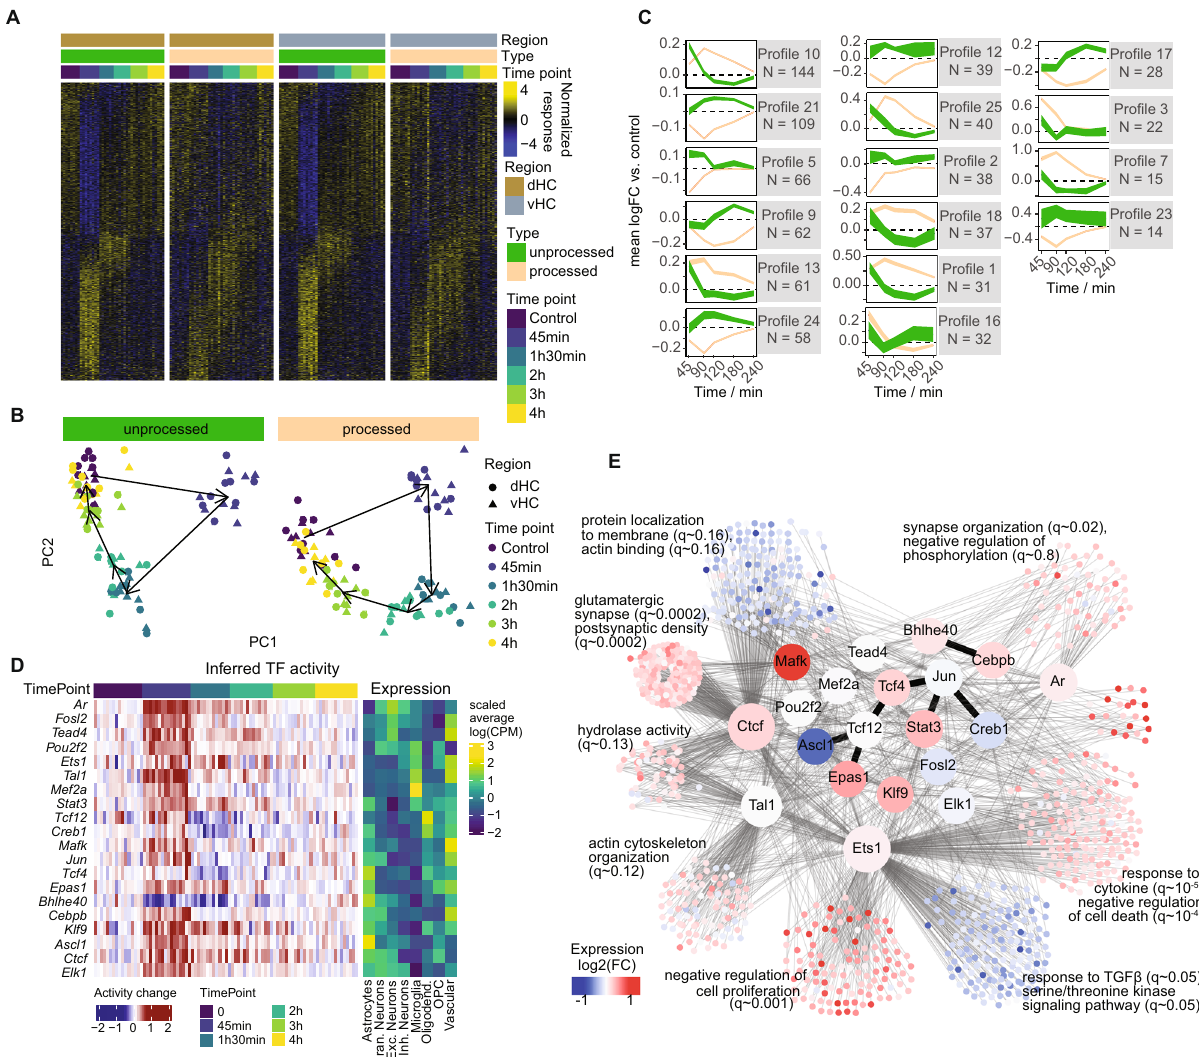
Fig. 3 Active nuclear transcription after acute stress. A Heatmap showing unprocessed (actively transcribed) vs processed transcripts of differentially expressed genes. B PCA plot of unprocessed and processed transcripts across differentially expressed genes. C Pro fi les from Fig. 2E resolved by unprocessed (green) and processed (brown) transcripts. D Relative activity of the most signi fi cant transcription factors (TF), inferred from the expression of their targets. The left panel shows inferred relative TF activity across bulk samples, while the right panel shows the relative average expression of the factors across cell types in the snRNAseq. E Network representation of the curated interactions between differentially expressed genes and the TFs found to be differentially active. Colours indicate the direction of differential expression at 45 mins. Thin lines represent transcriptional interactions, while dark, thick lines represent protein-protein interactions between the factors. For each cluster, the top GO enrichments are shown. CPM counts per